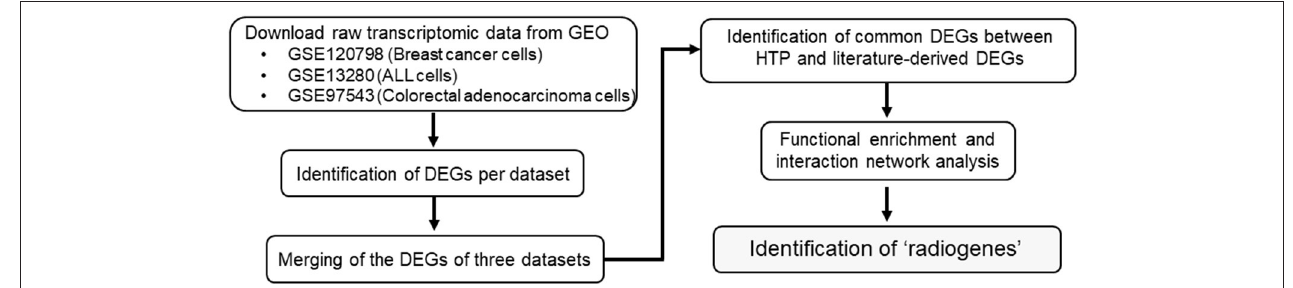
FIGURE 1 | Flowchart diagram of the overall methodology employed in this study. Three eligible transcriptome datasets were retrieved from NCBI’s GEO. Genes differentially expressed (DEGs) between the radioresistant and radiosensitive cancer cells were identified per dataset. The DEGs of the three analyzed datasets were integrated and compared with an earlier own study on cancer cell radioresistance-related genes/proteins derived from literature research. Functional enrichment analysis of the common genes was performed to obtain the so-called “radiogenes”.